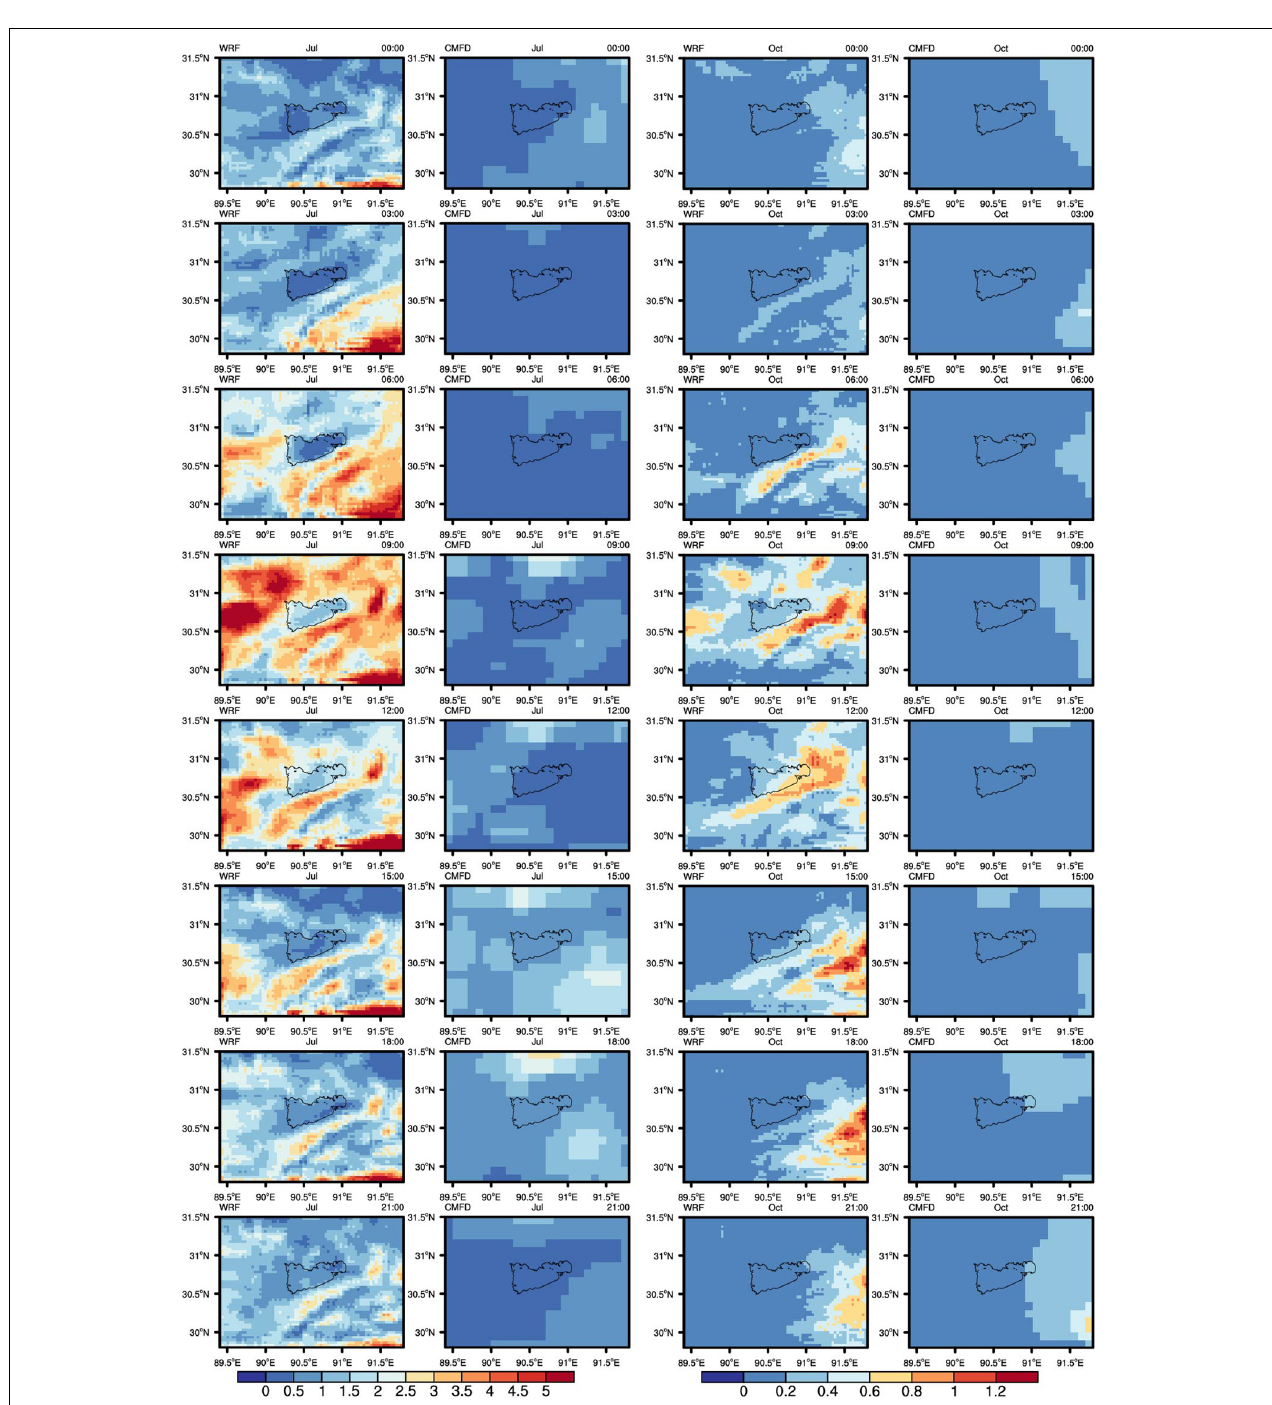
FIGURE 6 | Spatial distribution of monthly mean 3-h precipitation (shading, units: mm) from the WRF_lake simulation and the CMFD data in July (left two panels) and October (right two panels) of 2008.